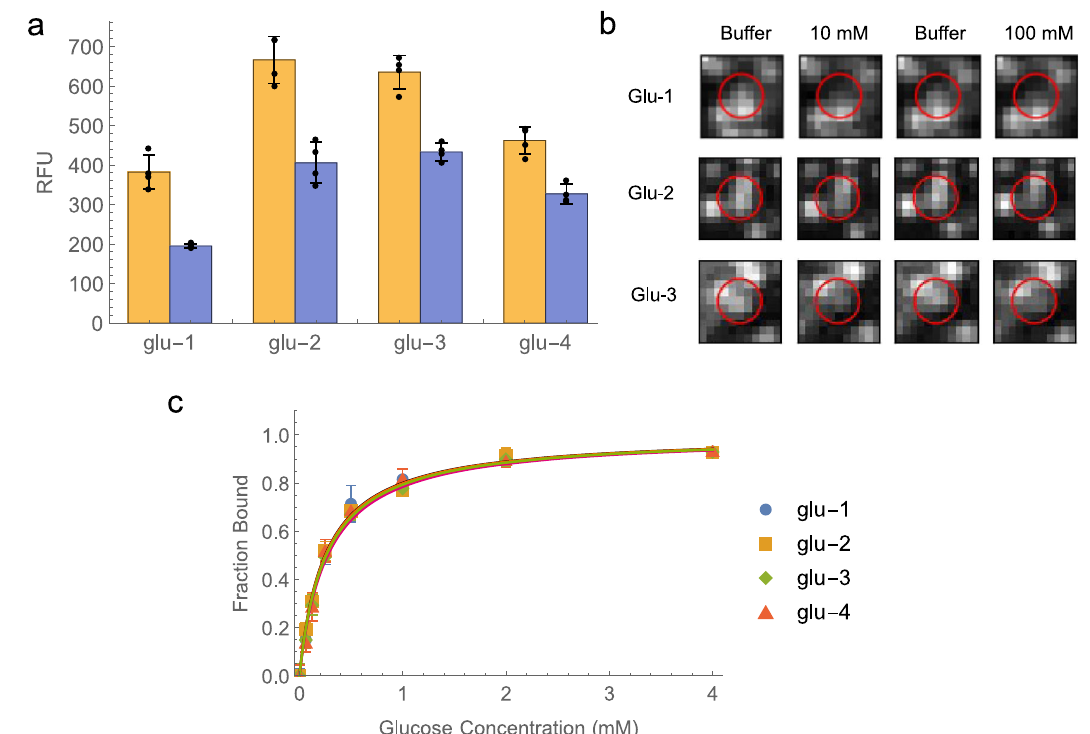
Fig. 5 | Identi fi cation and characterization of phenylboronic acid-modi fi ed aptamer switches for glucose. a Analysis of the top four aptamer switch clusters identi fi edinour fl ow-cellscreen.Orangeandbluebarsrepresentclusterintensityin buffer and 10mM glucose, respectively. Data are presented as mean values ( n =4 replicates) and error bars represent the standard deviation of the measurements. Individual data points are overlayed as black dots. Source data are provided as a SourceData fi le. b Extractedimagesofclustersglu-1, − 2,and − 3(redcircles)onthe